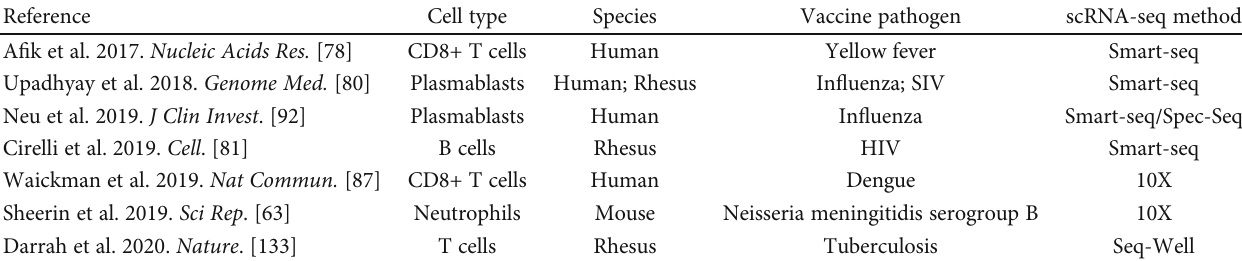
Table 1: Summary of prophylactic vaccinology publications using